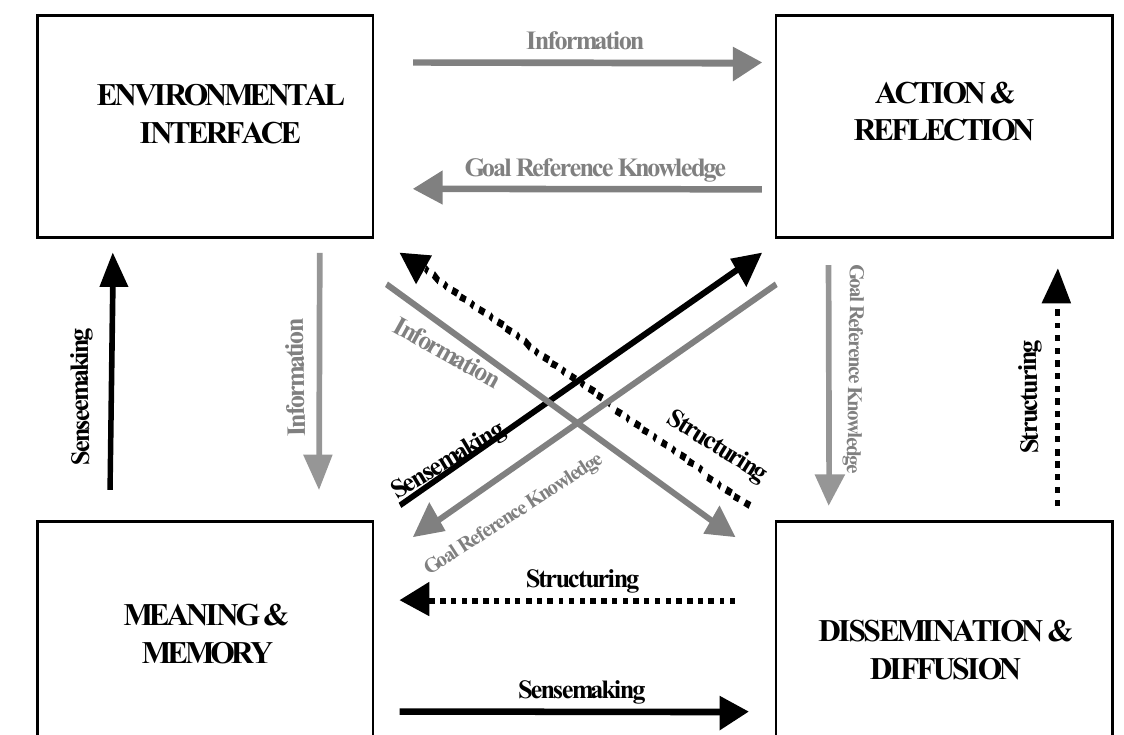
Figure 4: Media of interchange in Schwandt’s learning